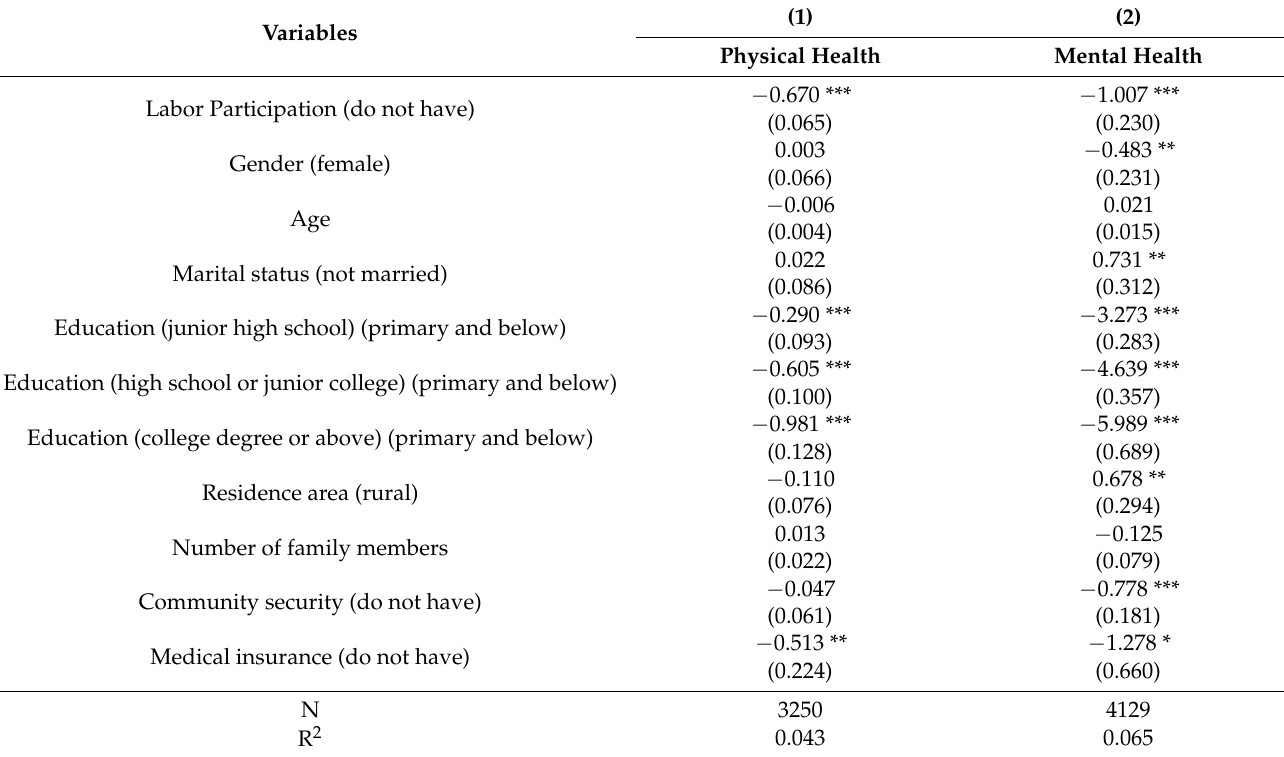
Table 3. Health of the elderly under different labor force participation